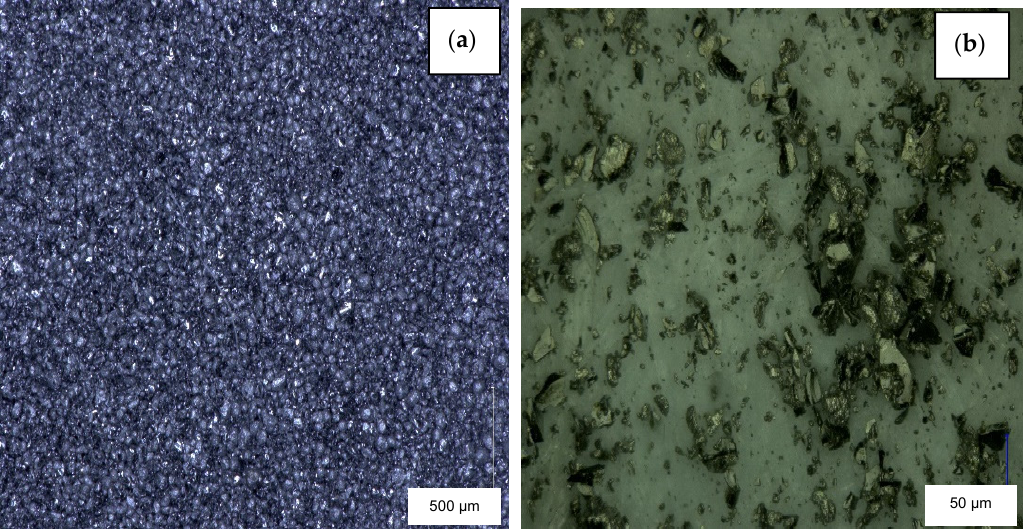
Figure 7. Microstructure of Al-W-B composite powders after grinding in disintegrator ( a , b ).